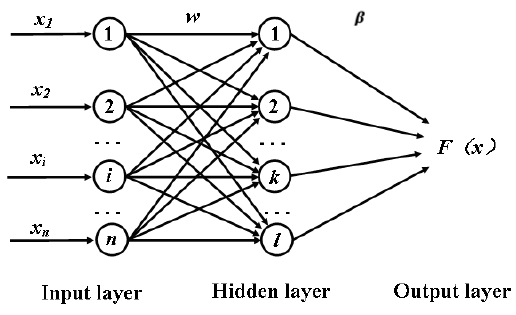
Figure 1. General structure of ELM.